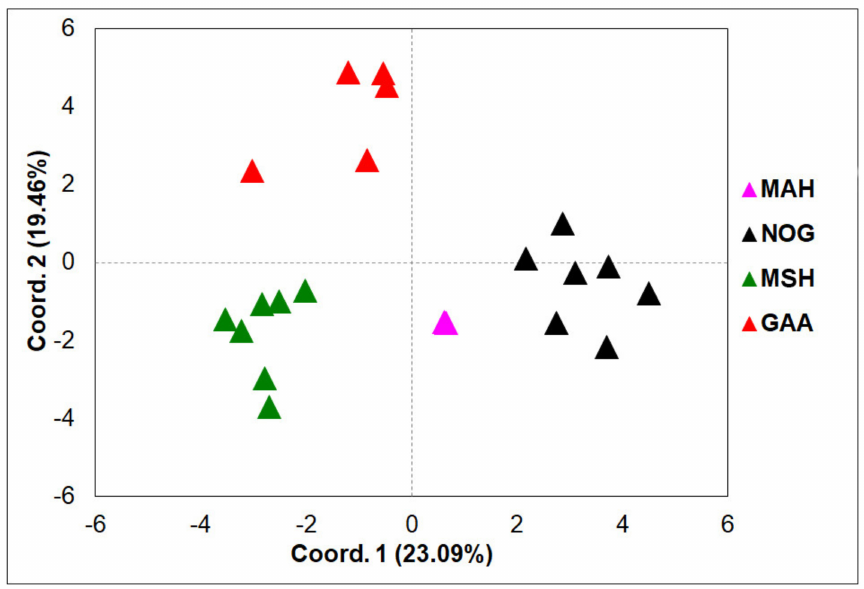
Figure 10. Principal Coordinates Analysis (PCoA) showing di ff erentiation patterns among invasive A. franciscana populations based on ISSR markers (abbreviations listed in Table